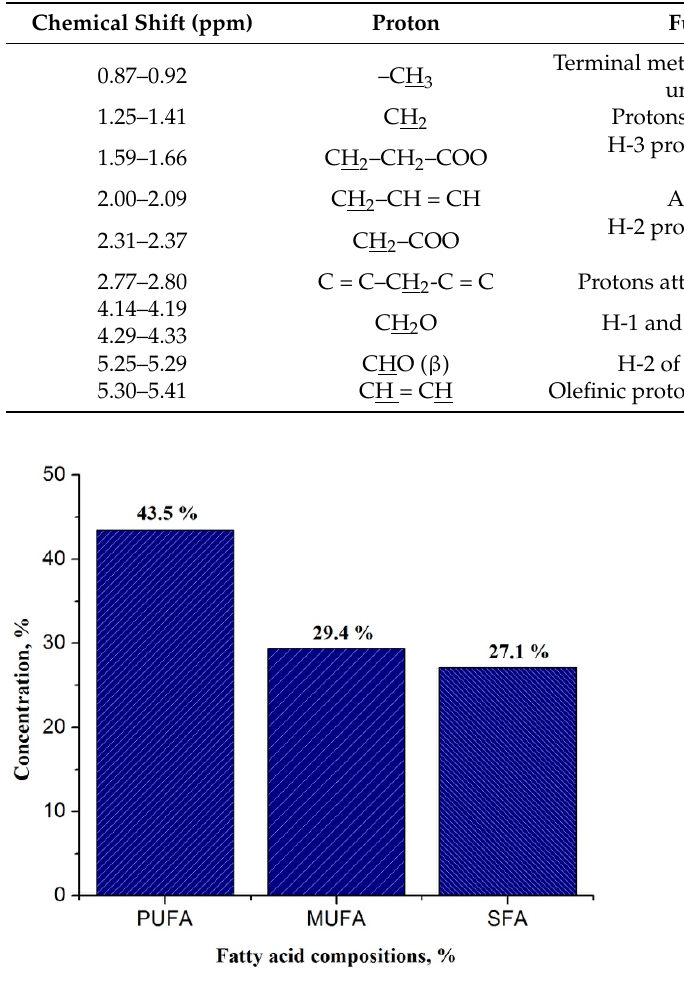
Figure 3. Relative % of saturated (SFA), monounsaturated (MUFA) and polyunsaturated fatty acids (PUFA) as determined using 1 H-NMR.